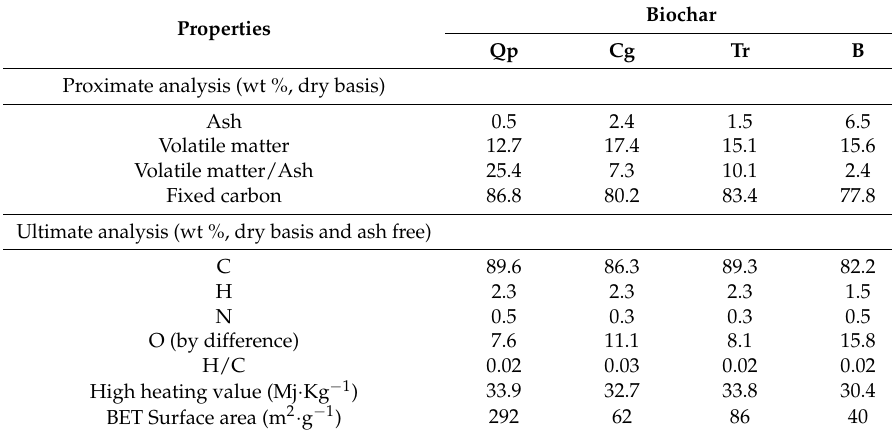
Table 1. Physicochemical characteristics of